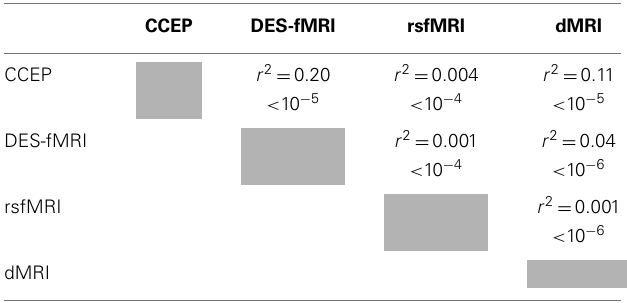
Table 3 | Paired comparison of four methods for brain connectivity